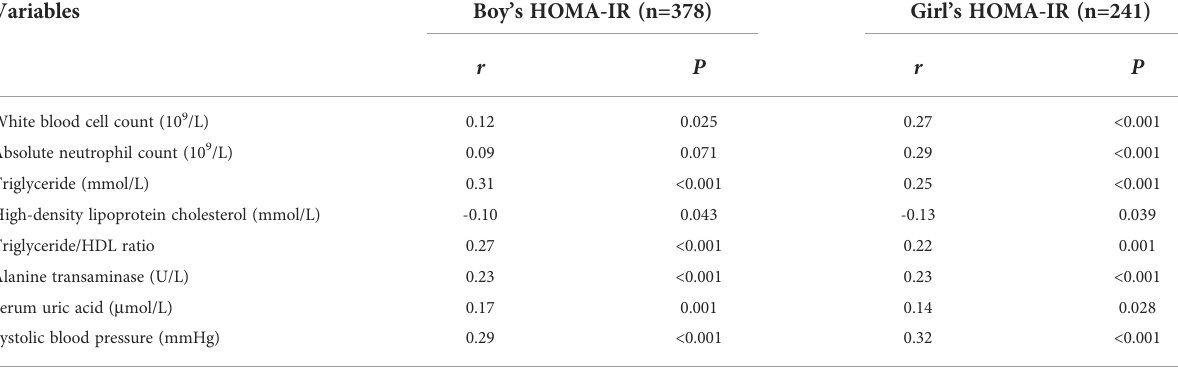
TABLE 4 Sex differences in partial correlation analysis of HOMA-IR and clinical indicators adjusted for age in children with overweight and obesity.